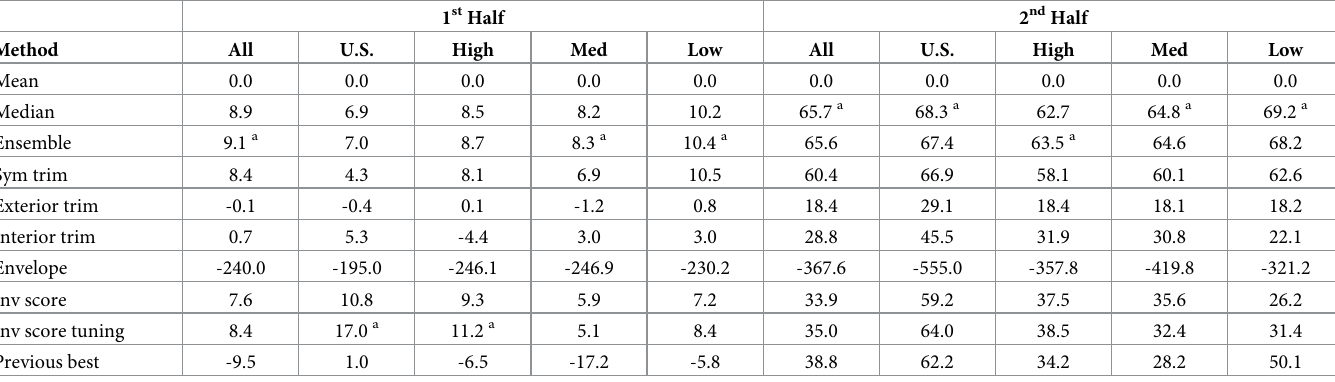
Table 10. For cumulative mortality, skill scores for MWIS calculated separately for the first and second halves of the 78-week out-of-sample period. 1 st Half 2 nd Half Method All